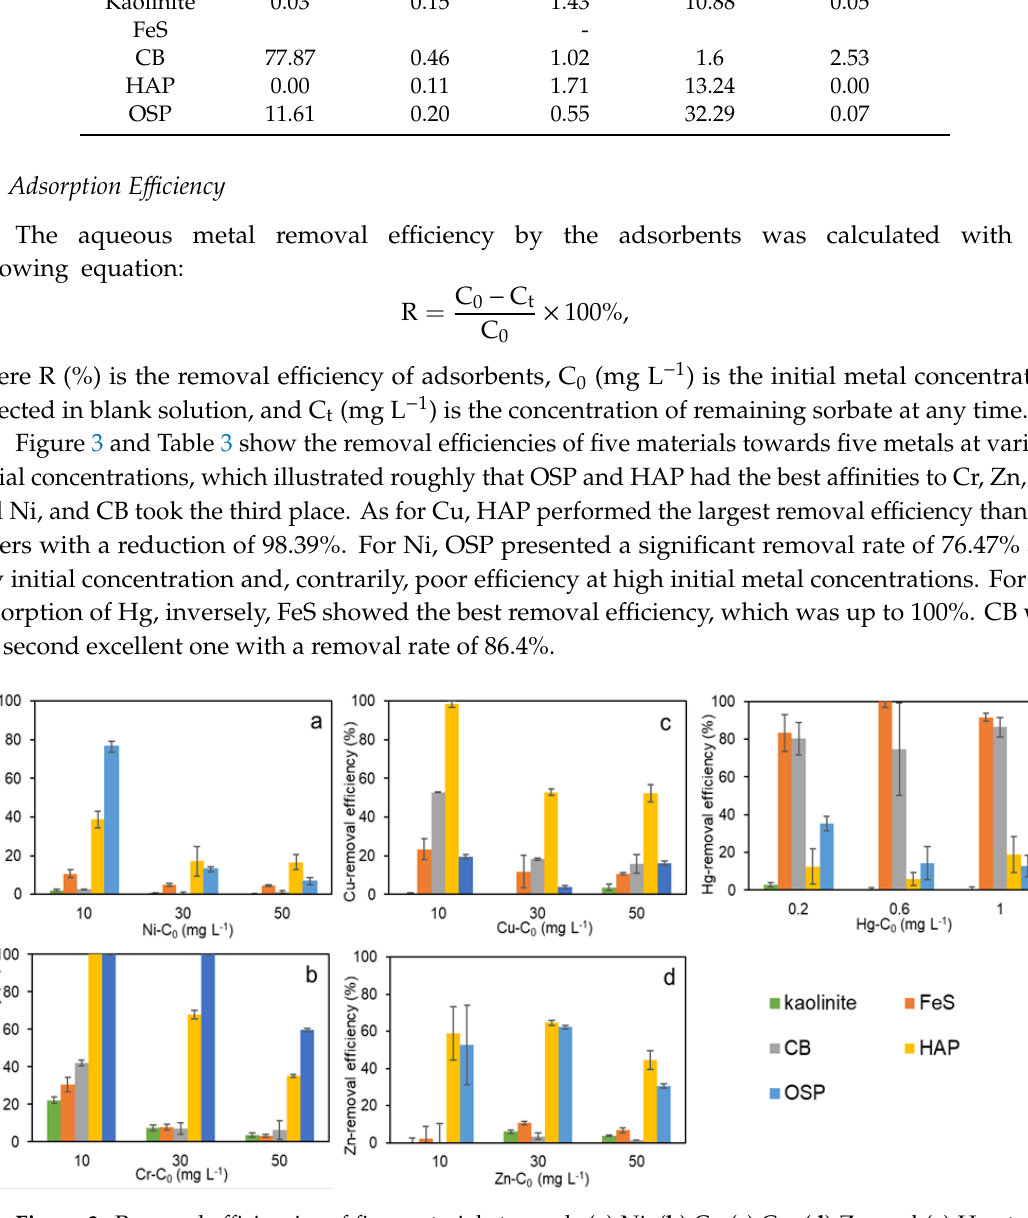
Figure 3. Removal efficiencies of five materials towards ( a ) Ni, ( b ) Cr, ( c ) Cu, ( d ) Zn, and ( e ) Hg at various initial concentrations.